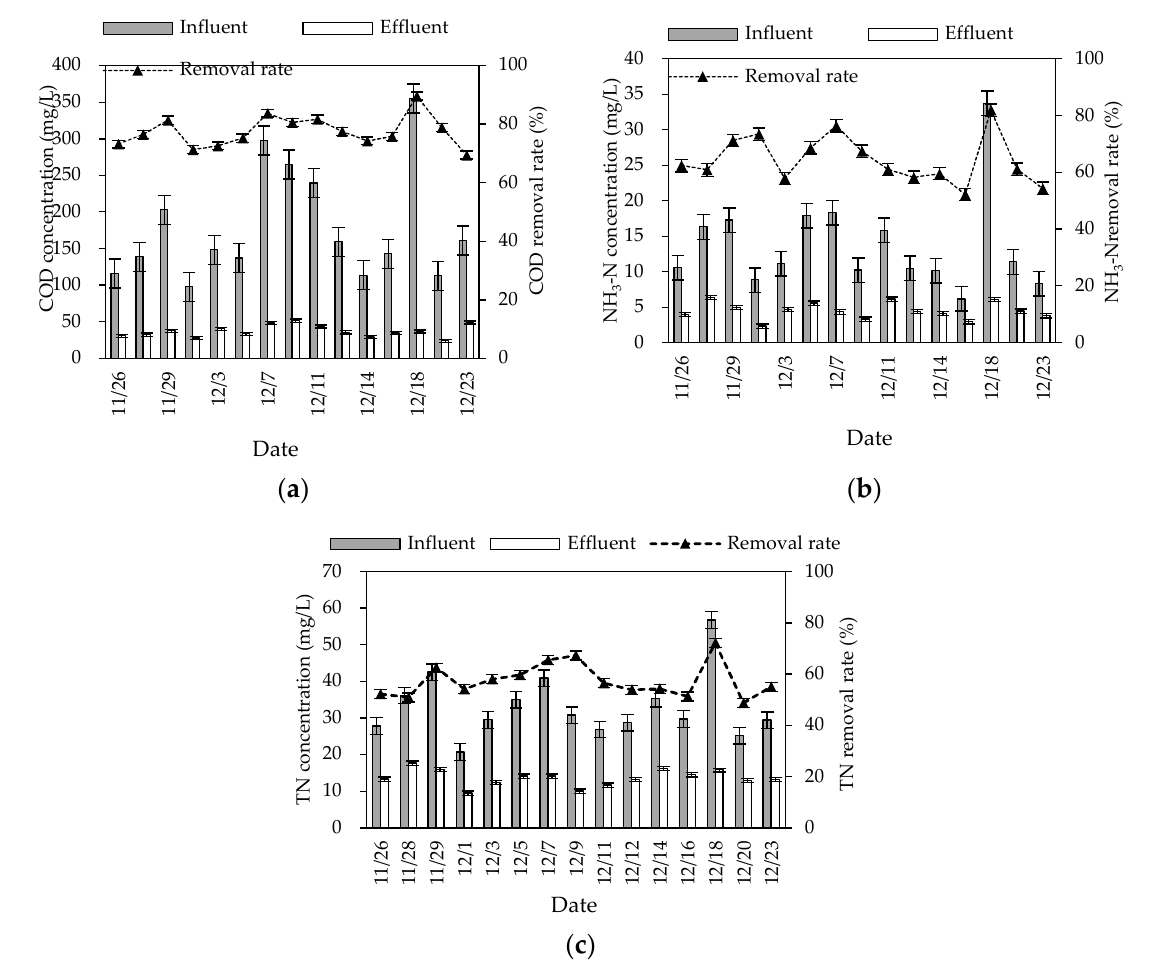
Figure 3. Winter inlet and outlet COD ( a ), NH 3 –N ( b ), and TN ( c ) concentrations and removal rates of the combined